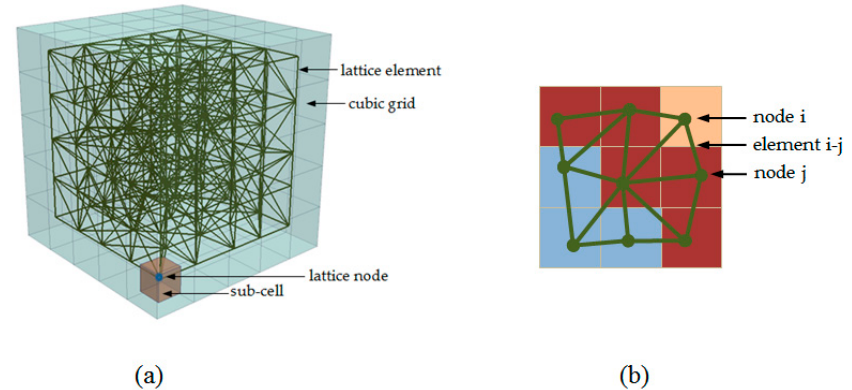
Figure 1. ( a ) Node and mesh generation procedure; ( b ) an example of the overlay procedure for cement paste, shown in 2D for simplicity (pink—outer product, red—inner product, light blue—unhydrated cement), adapted from [77].